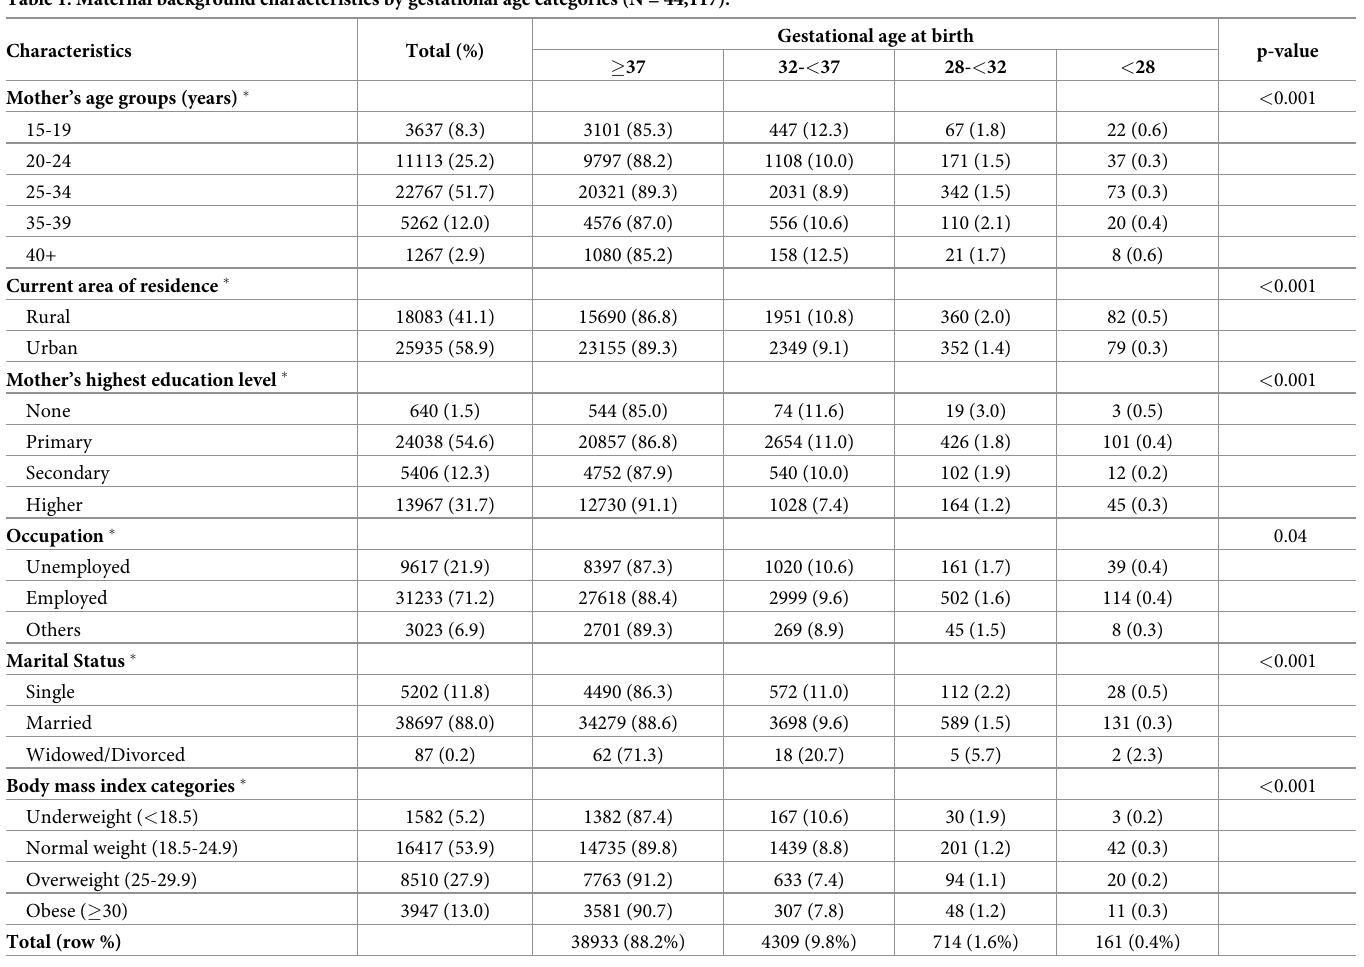
Table 1. Maternal background characteristics by gestational age categories (N =